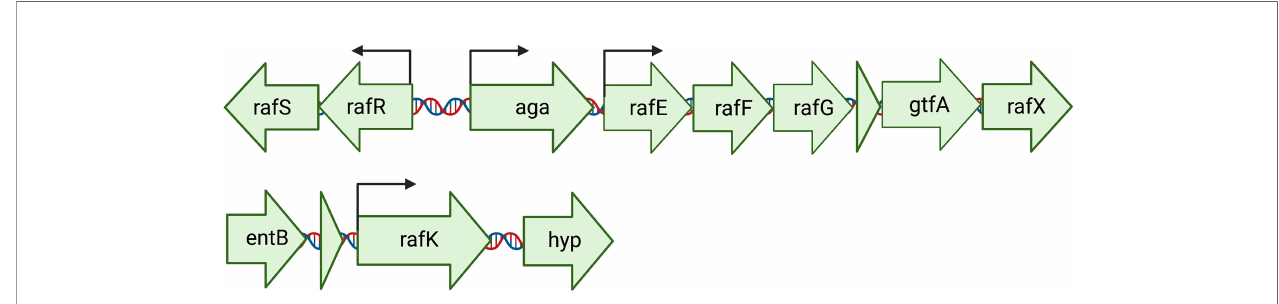
FIGURE 2 | Arrangement of the genetic loci required for the import and utilization of raf fi nose by S. pneumoniae . The main locus contains 8 genes: an ABC transporter with solute-binding protein and two cognate permeases ( rafE , rafF and rafG ); two transcriptional regulators, rafS (repressor) and rafR (activator), which control the expression of the gene encoding an a -galactosidase ( aga ); a sucrose phosphorylase ( gtfA ), and rafX , encoding a gene of unknown function. Further upstream is rafK , encoding an ATP-binding protein, essential for raf fi nose import into the cell (Rosenow et al., 1999). Arrows above the genes indicate locations of promoters. Created